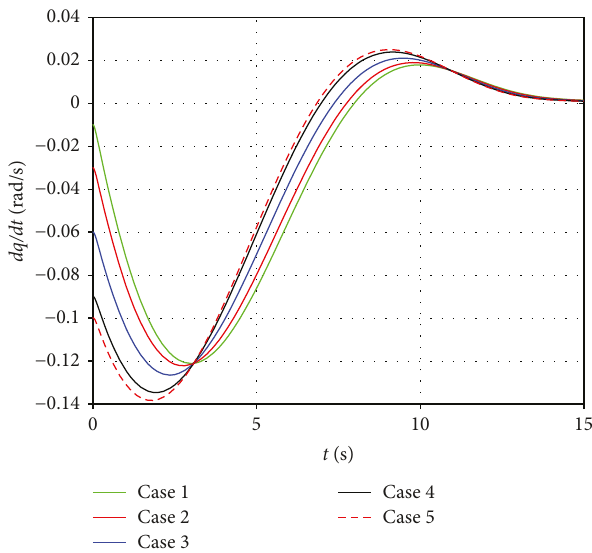
Figure 23: LOS angle rotation rate variation of Defender